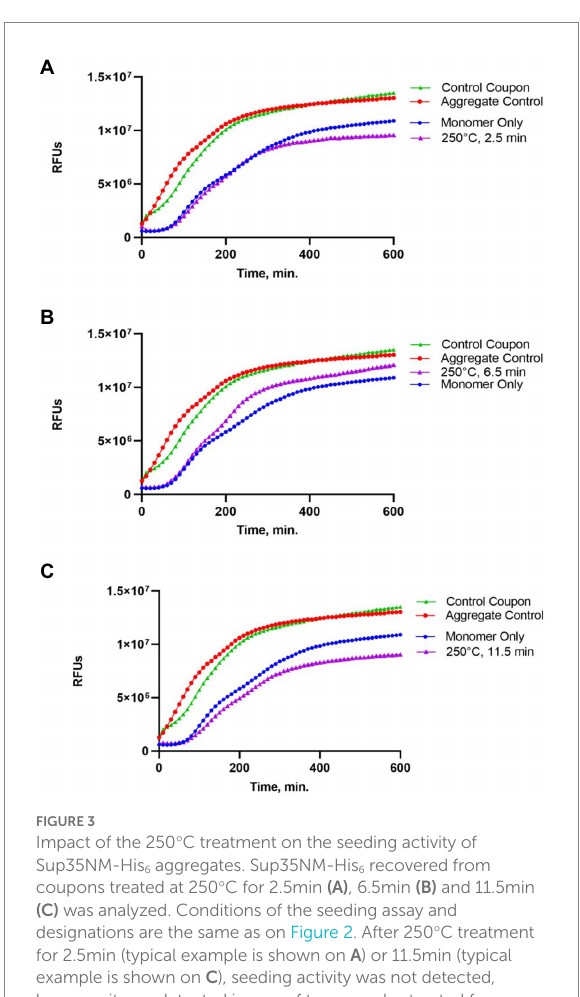
FIGURE 4 Impact of the 350 ° C treatment on the seeding activity of Sup35NM-His 6 aggregates. Sup35NM-His 6 recovered from coupons treated at 350 ° C for 2.5 min (A) , 6.5 min (B) and 11.5 min (C) was analyzed. Conditions of the seeding assay and designations are the same as on Figure 2. Weak seeding activity was detected in one out of two samples treated at 350 ° C for 2.5 min (shown on A ), and in one out of two samples treated at 350 ° C for 6.5 min (shown on B ), but it was not detected in any of 5 samples treated at 350 ° C for 11.5 min (a typical example is shown on C